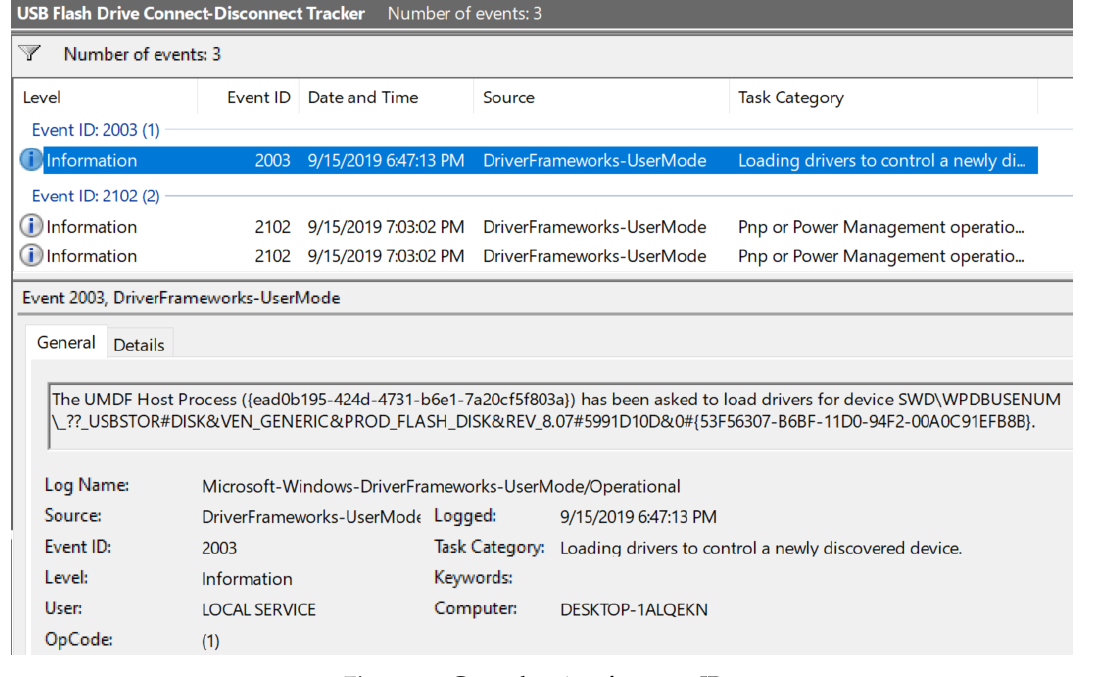
Figure 12. Group by view for event